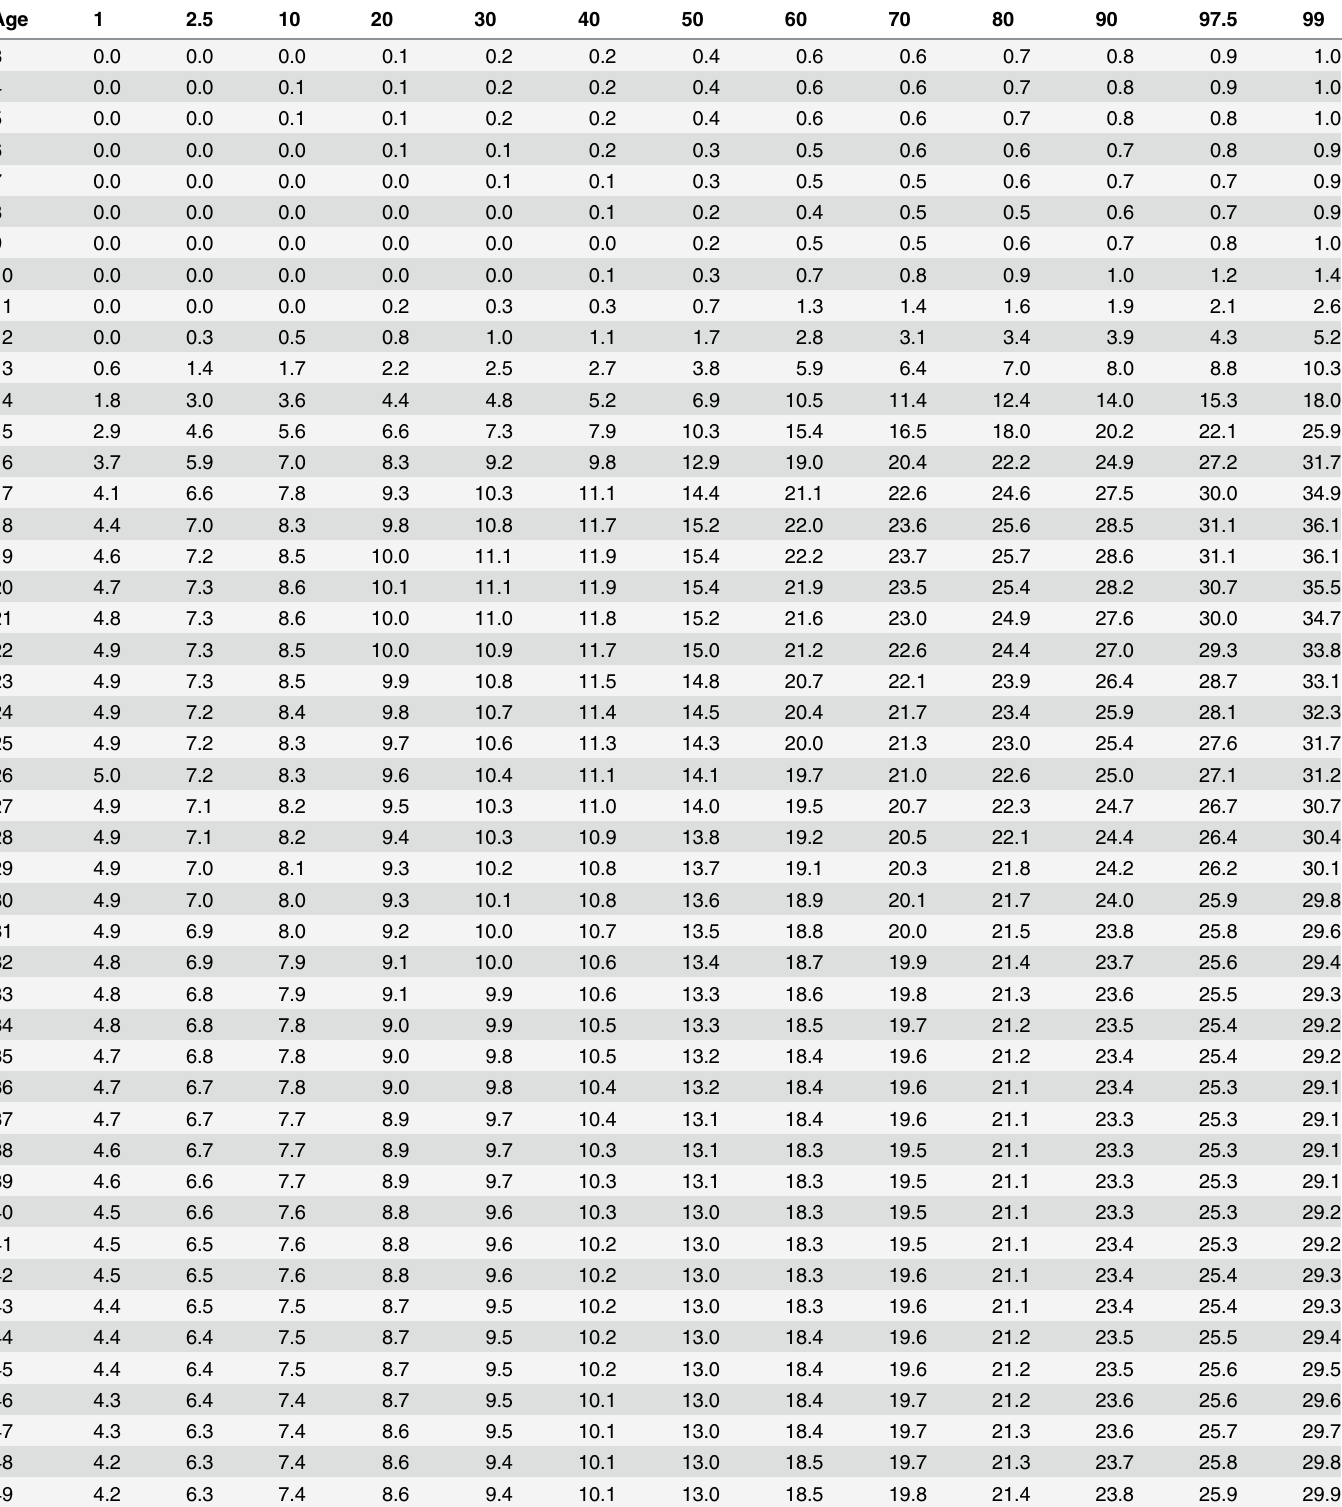
Table 3. Normative age-related total testosterone reference values in nmol/L. Ages are in years; column headings are